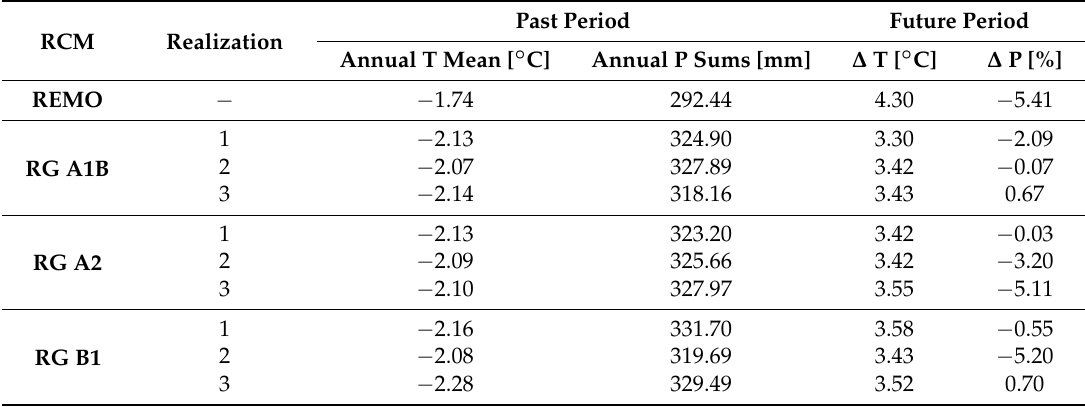
Table 2. Annual temperature mean, and annual precipitation sums of the Past period and percental changes of the future period of all scenario realizations.